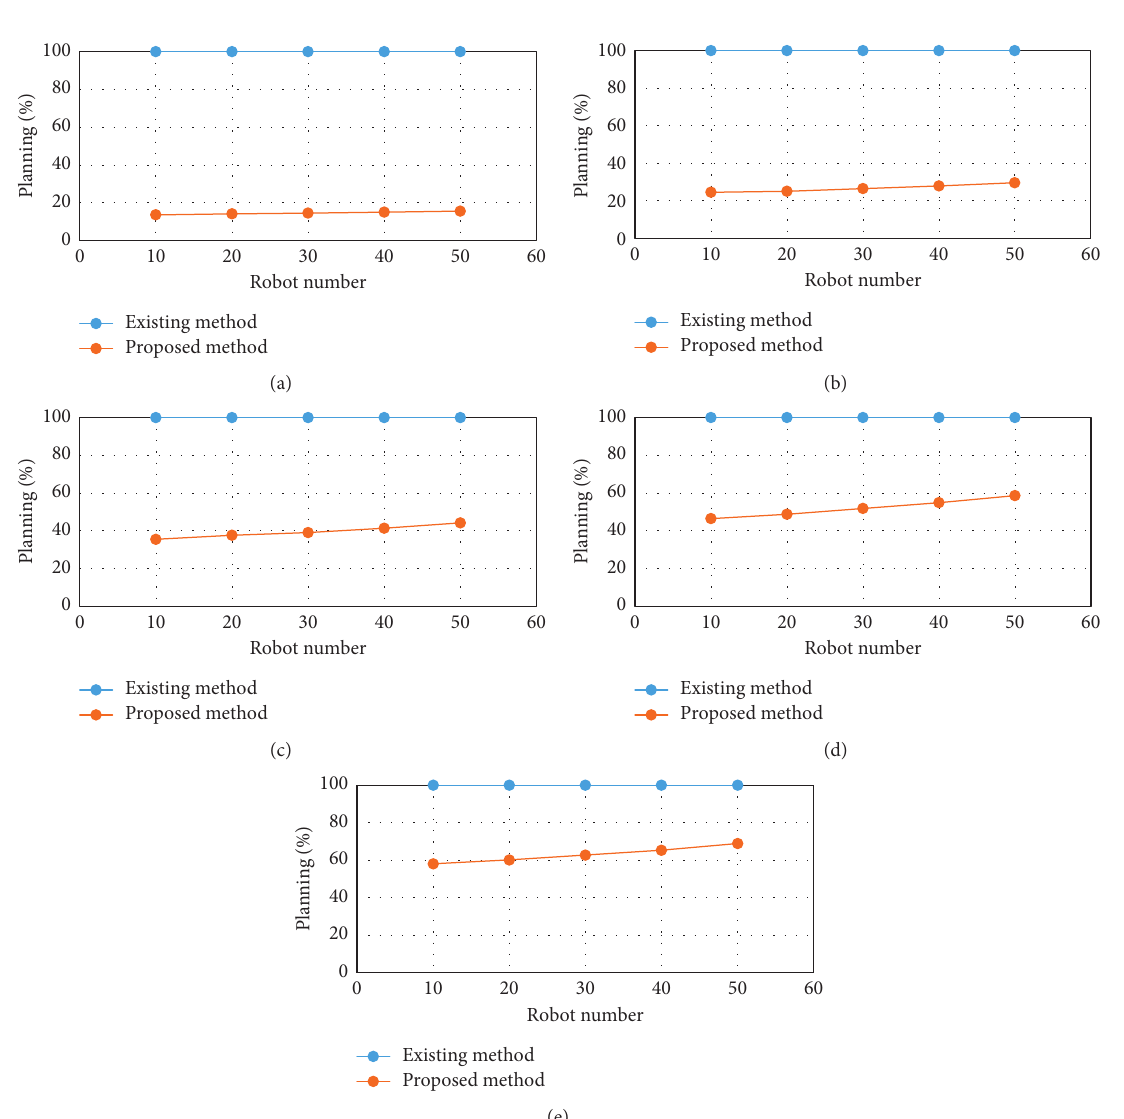
� 0.1. (b) p � 0.2. (c) p � 0.3. (d) p � 0.4. u u u u